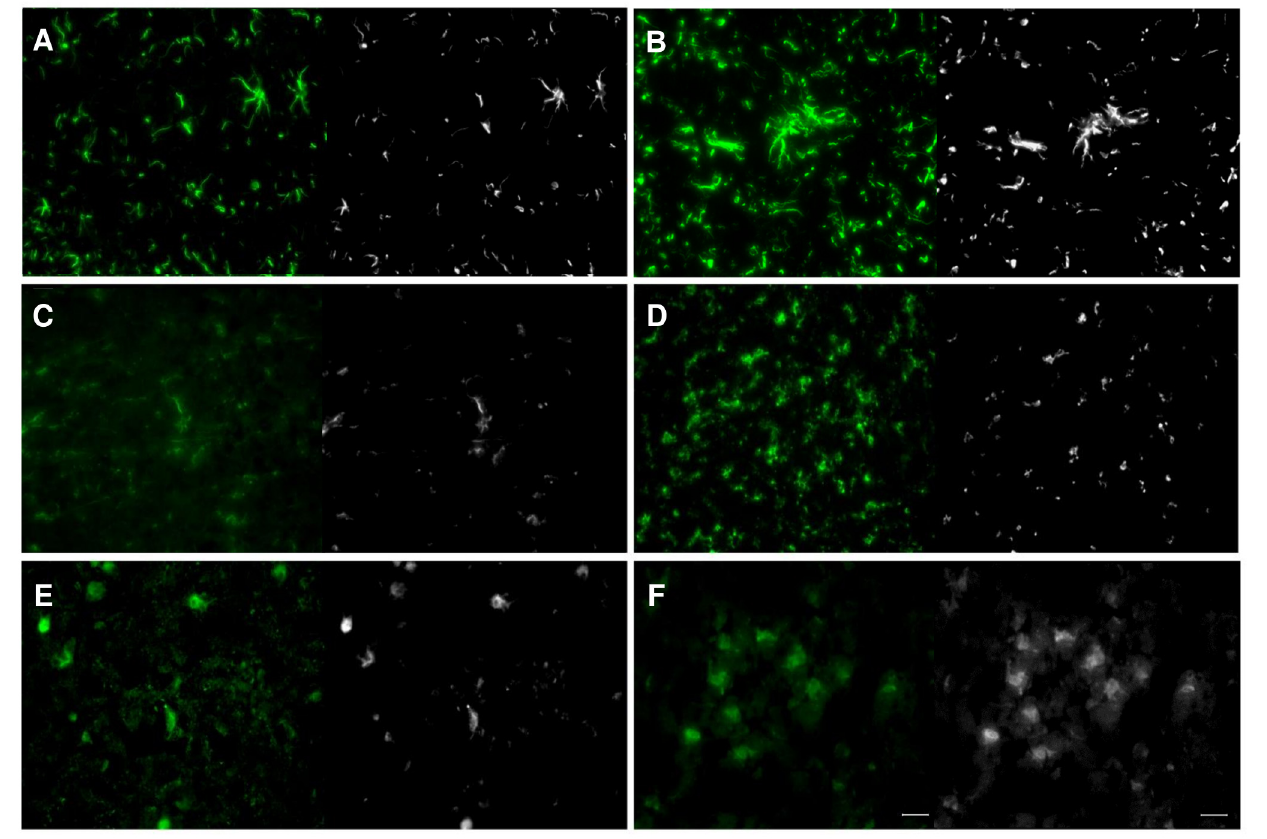
Fig 2. Typical images of control and morphine-tolerant cells in the spinal cord and their preprocessed images. (A) Astrocytes of the saline control. (B) Astrocytes with morphine tolerance. (C) Microglial of the saline control. (D) Microglial with morphine tolerance. (E) Neurons of the saline control. (F) Neurons with morphine tolerance. Scale bar represents 25 μ